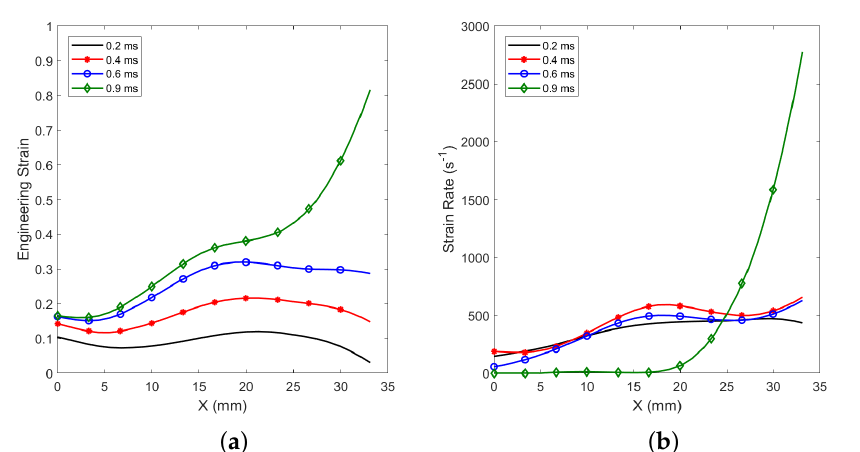
Figure 10. Evolution of spacial distribution of local longitudinal ( a ) strain and ( b ) strain rate. X = 0 mm stand for the material particles at the output interface, meanwhile X ≈ 34 mm stand for the material particles at the input